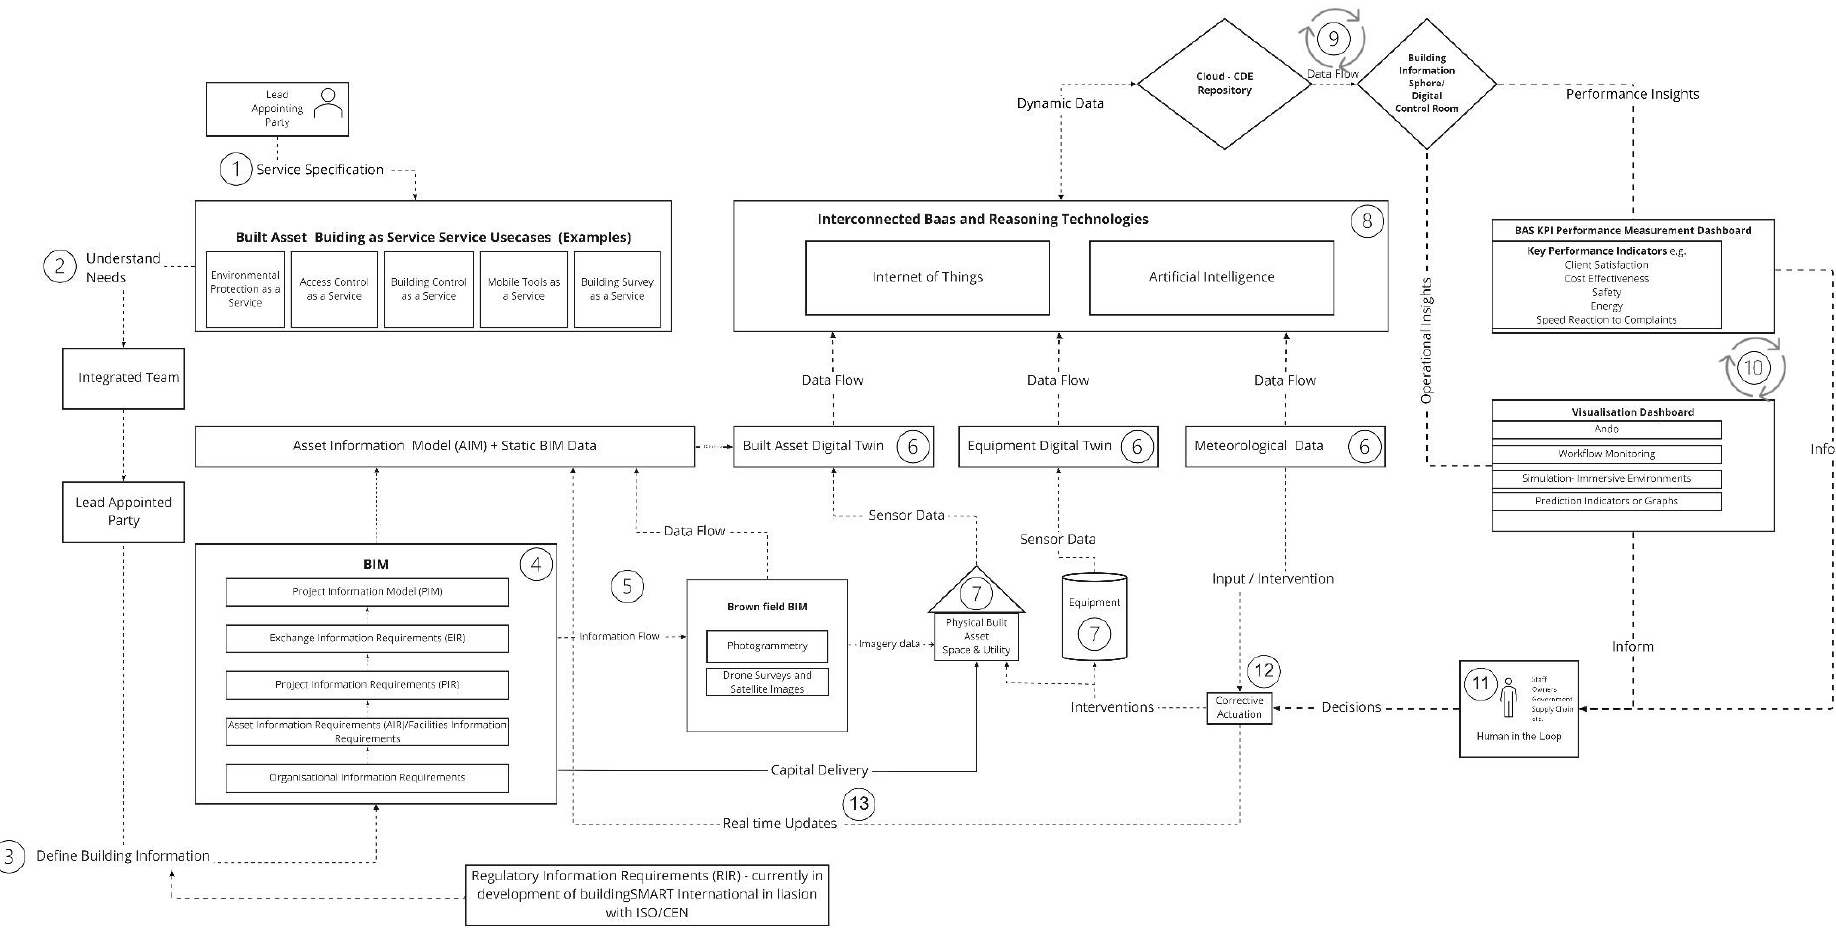
Figure 3. Conceptual framework for the implementation of “ Building-as-a-service ”.